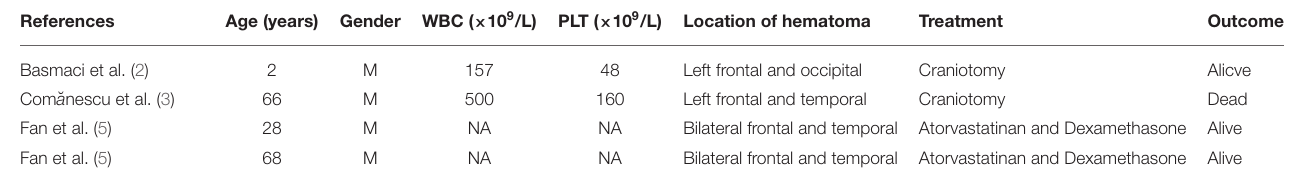
TABLE 1 | Reported cases of CSDH caused by